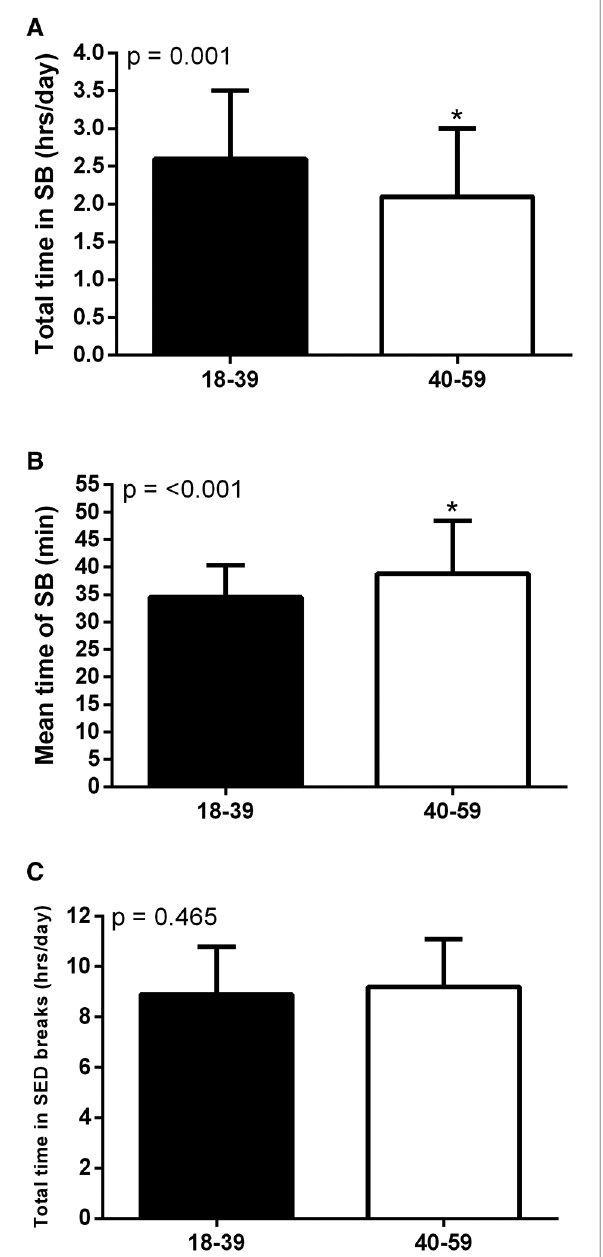
FIGURE 3 Total time in sedentary bouts ( A ), mean time of sedentary bouts ( B ) and total time in sedentary breaks ( C ) by age group. *Signi fi cant difference between age